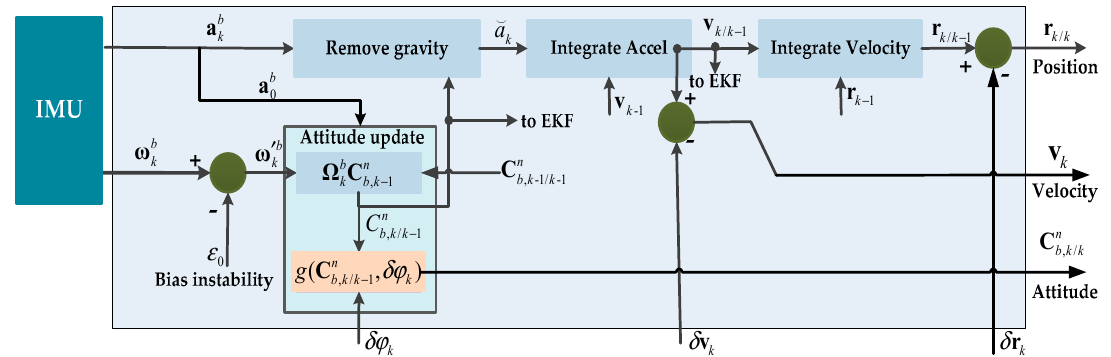
Figure 2. The inertial navigation system (INS) mechanization using the extended Kalman Filter (EKF) framework.